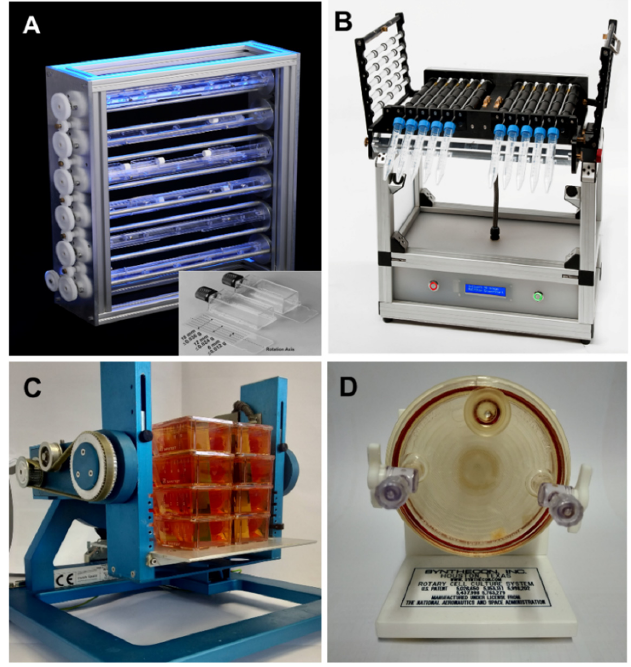
Figure 1. Ground-based facilities: ( A ) 2D clinostat for adherent cells in slide flaks (Insert in A demonstrates residual accelerations depending on speed of rotation (here 60 rpm) and diameter) or ( B ) for suspended cells in pipettes. ( C ) Random Positioning Machines equipped with slide flasks (mL) for thyroid cancer cells. ( D ) NASA-developed Rotating Wall Vessel.